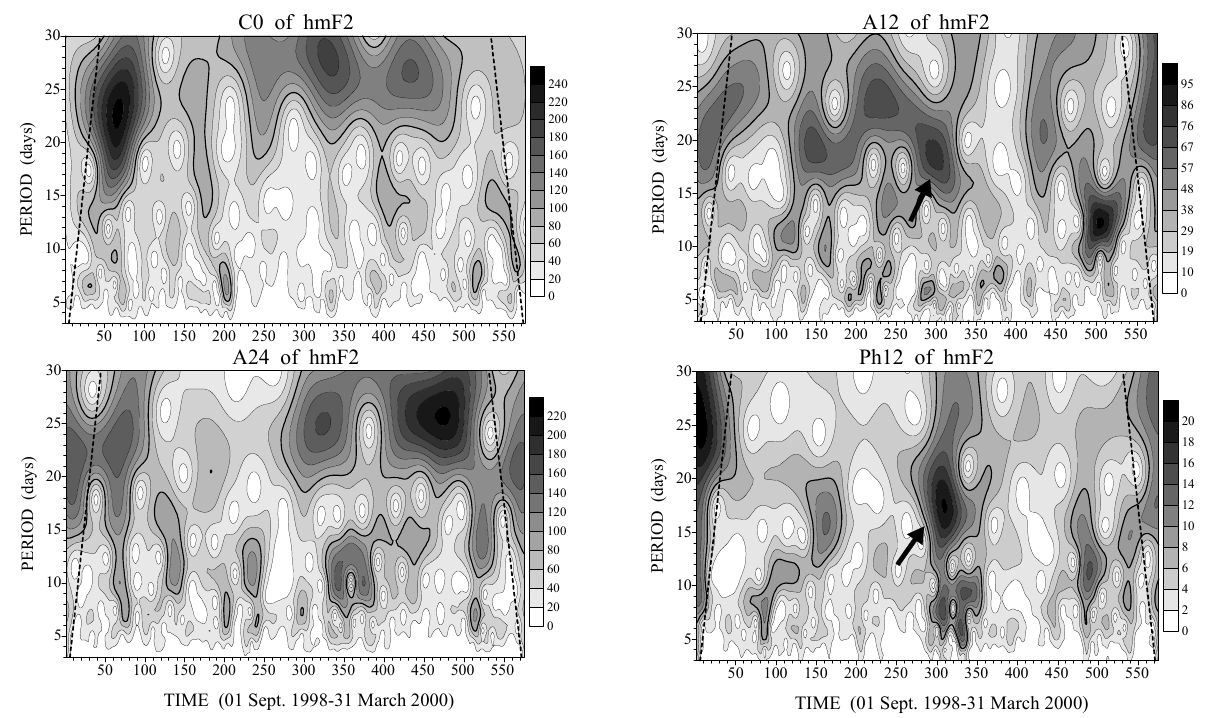
Fig. 9. The wavelet spectra of the diurnal mean (upper left plot), the amplitude of 24- (lower left plot) and 12-h (upper right plot) periodicities of the hm F2 and the phase of the 12-h periodicity of the hm F2 (lower right plot) in the period range